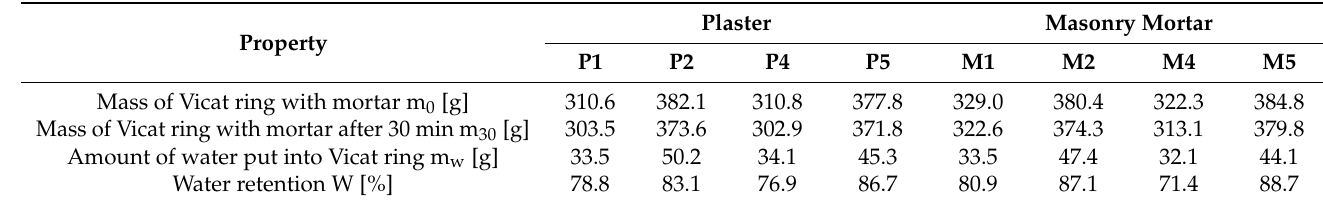
Table 6. Results of water retention